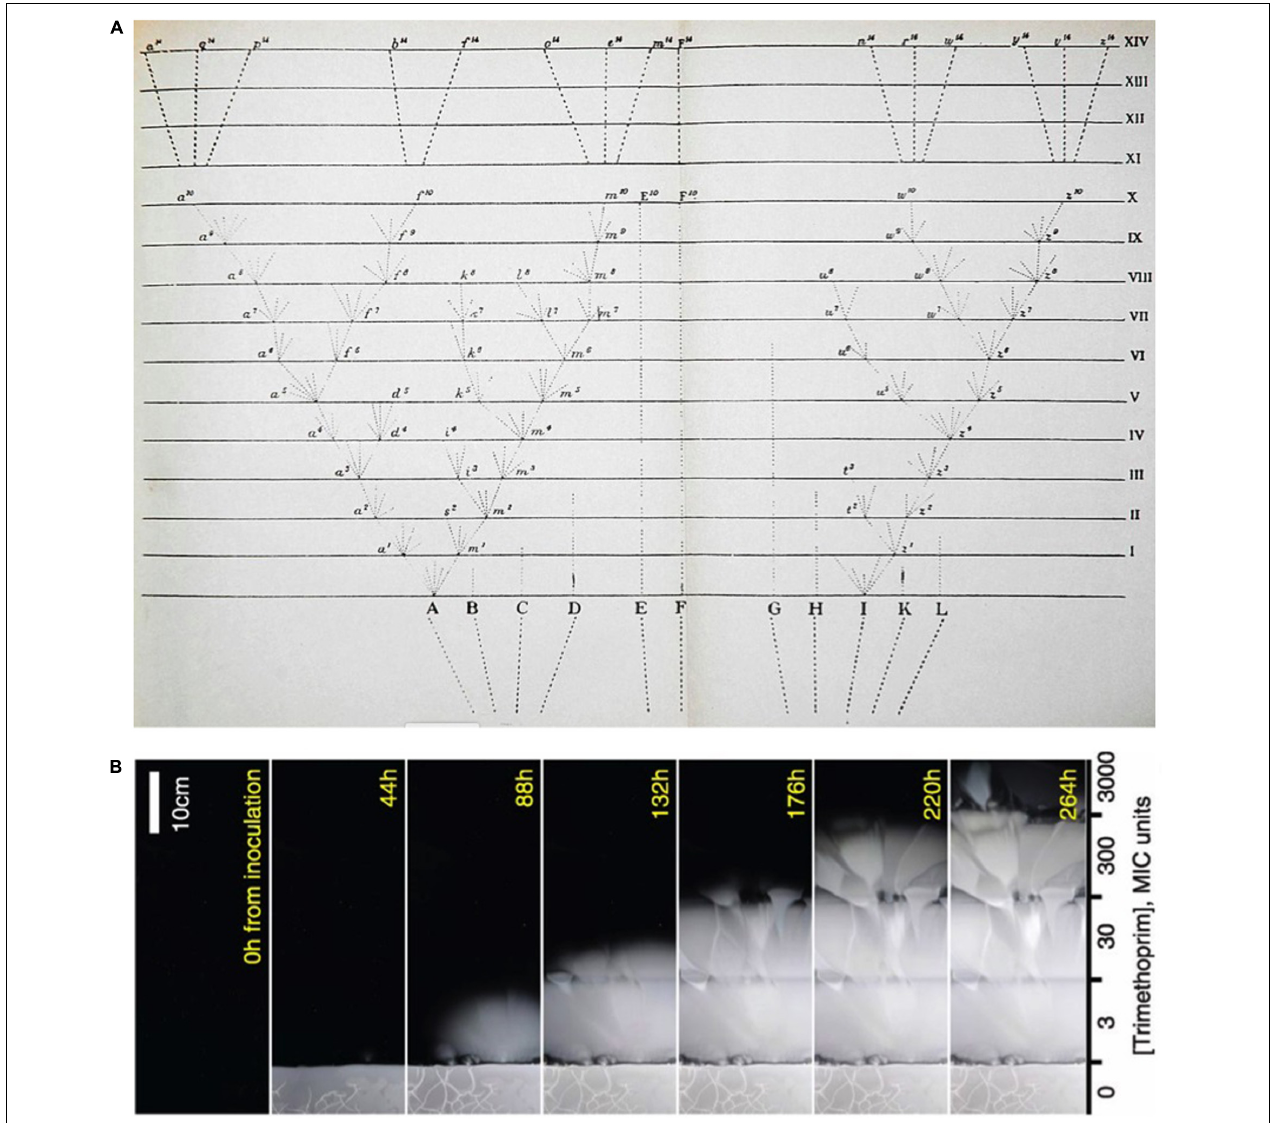
FIGURE 2 | (A) Darwin’s “Tree of Life” diagram from his Origin of Species (Darwin, 1860) juxtaposed with (B) a time-lapse study of bacterial growth across a step-wise concentration gradient of antibiotic (Baym et al., 2016). A video of this marvellous experiment may be accessed here: https://www.youtube.com/watch?v=plVk4NVIUh8.